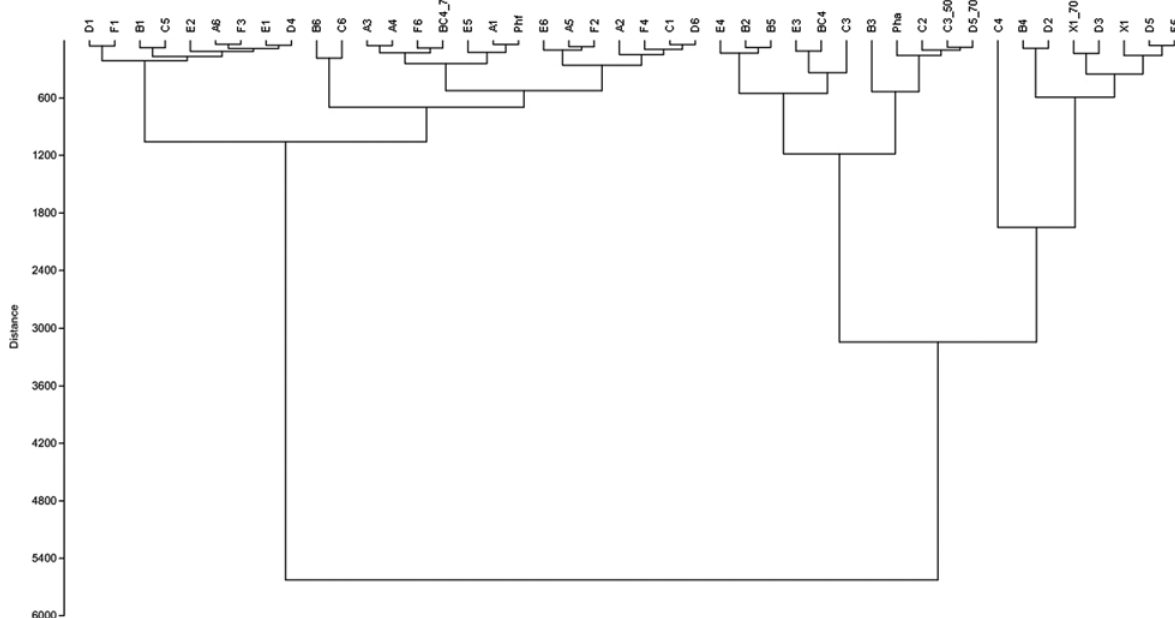
Fig. 4. Cluster analysis for the contaminant (using Ward’s method PAST version